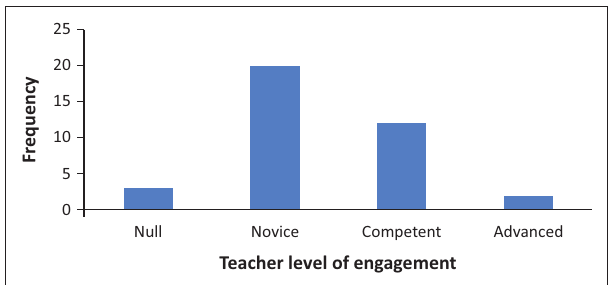
FIGURE 7: Response of participant MAD 282 to Task 3.